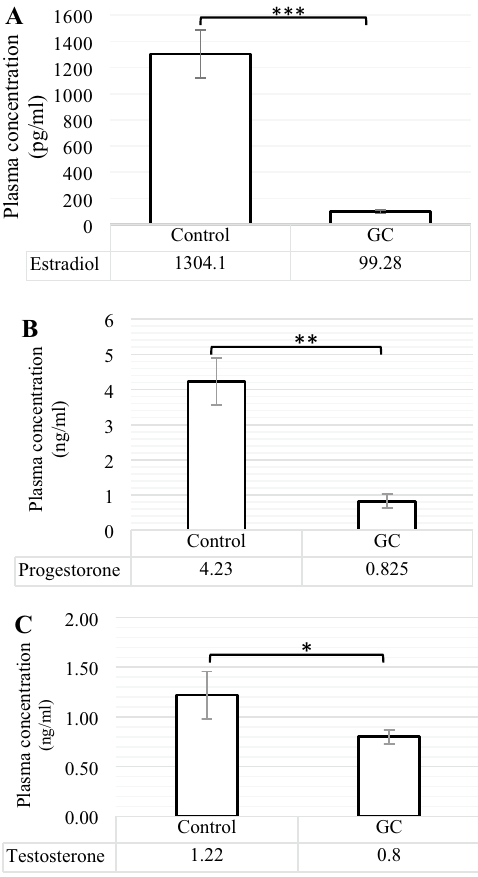
Figure 2. The comparison of plasma Estradiol ( A ), Progesterone ( B ), and Testosterone ( C ) contents between control and GC (Glucocorticoid Fluticasone, 2 ppm). Different statistical marks are significant (*P ≤ 0.05, **P ≤ 0.01, and ***P ≤ 0.001) according to the Dunnett’s test as a comparison